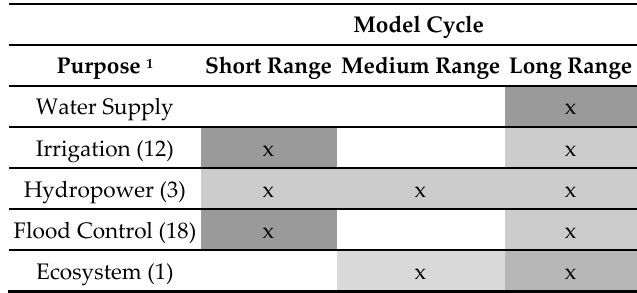
1 numbers in the parentheses denotes the reservoir count in this study; “x” indicates that the cycle is relevant for the project purpose; dark grey = highly relevant, light grey = potentially relevant.